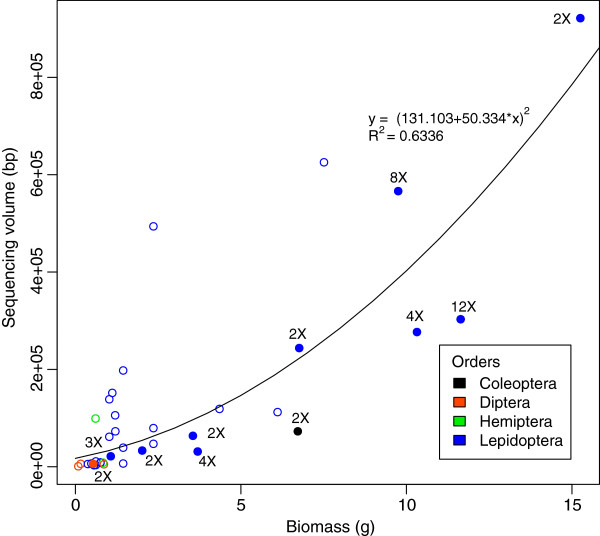
Correlation between biomass and data volume. The sequence volume for each given taxon was measured by number of base pairs. The corresponding biomass was estimated based on the body-length. Hollow circles represents the taxa with a single individual, while solid circles represents the taxa with multiple individuals. Number of individuals in the corresponding MOTU is also labeled on the solid circle. Small taxa were typically sequenced at lower sequencing volumes. But those represented by multiple individuals had higher sequencing volume. The increase of sensitivity for these small insects was likely a consequence of the increased total biomass for the given species.